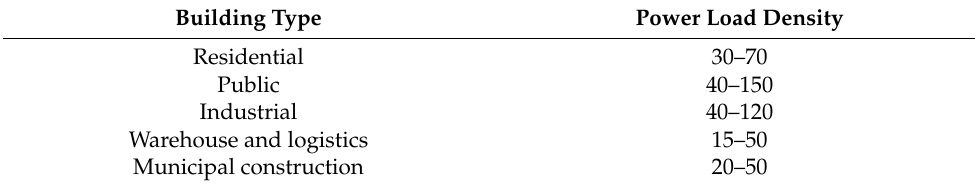
Table 6. Power load density for different types of buildings [53].